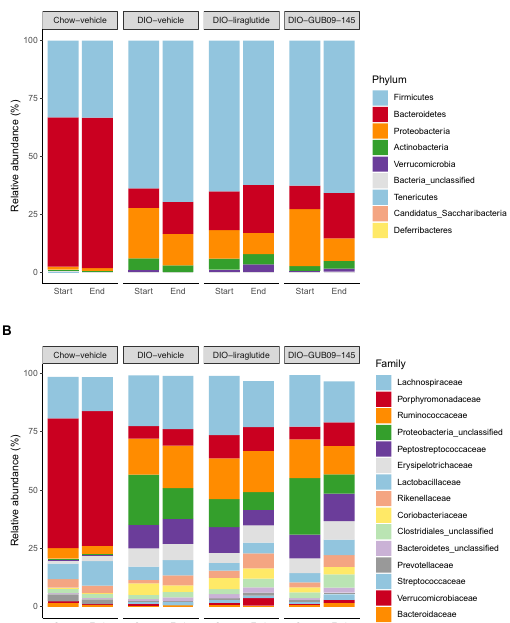
Figure 3. Taxonomic summary at phylum and family level. Mean values per group are illustrated of the nine detected phyla (panel A) and the 15 most abundant families (panel B) across all samples. The phyla and families are sorted with the highest abundance across all samples in the top. For panel B, note that bar height for liraglutide and GUB09-145 (endpoint data) is slightly lower compared to baseline, reflecting that terminal samples showed a relatively higher proportion of reads not mapping to the top-15 most abundant